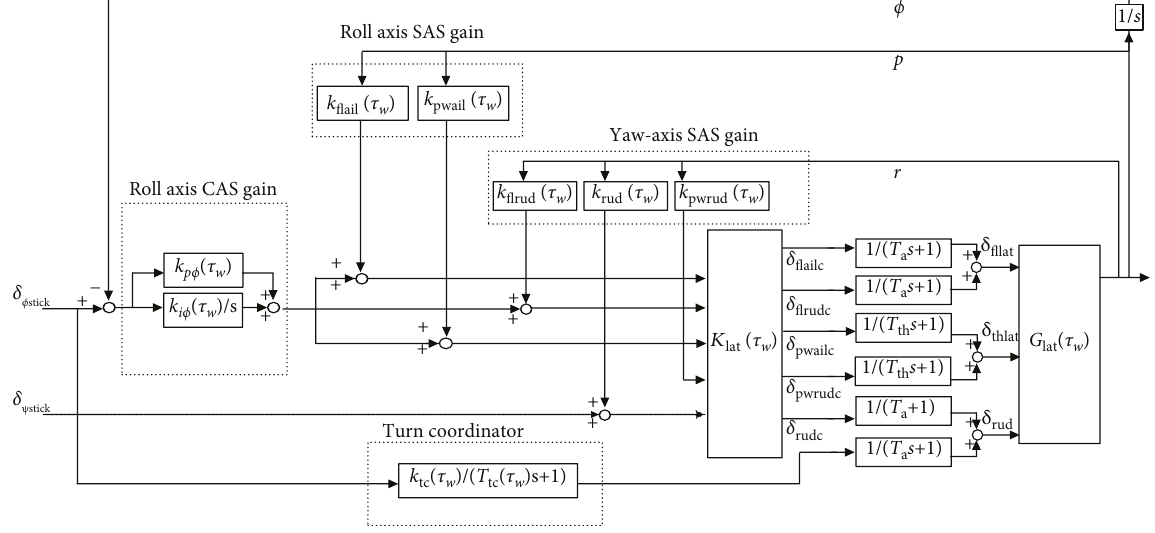
Figure 3: Block diagram for lateral-directional motion control of McART3 used in